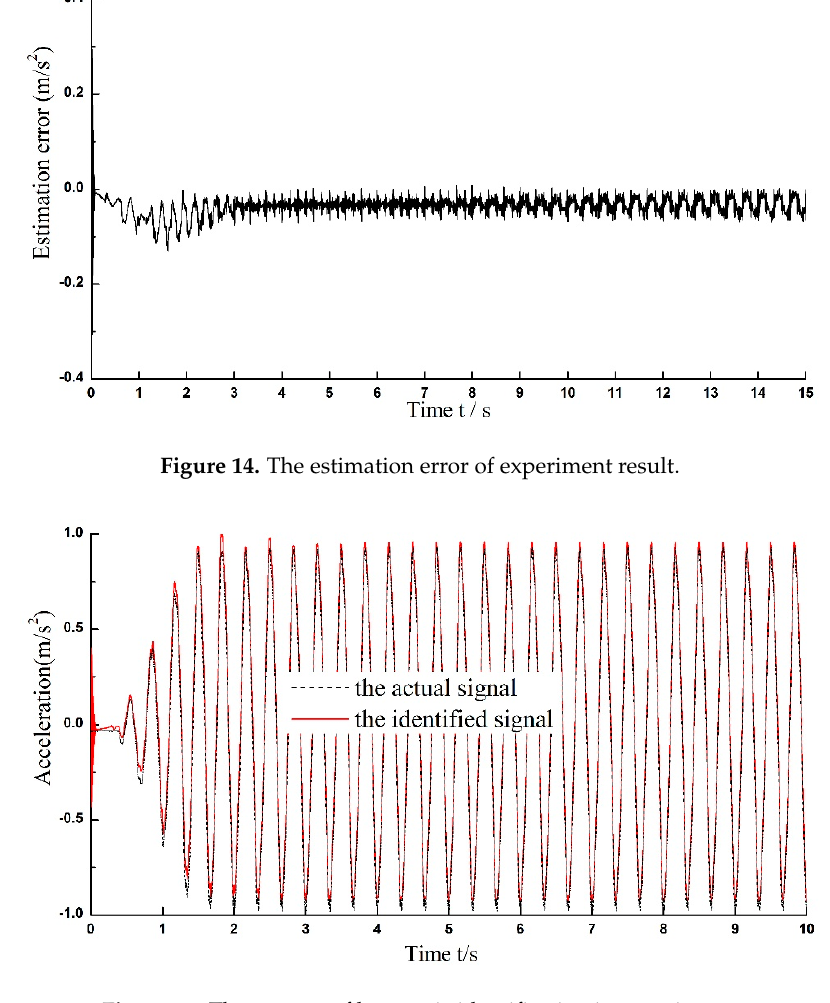
Figure 15. The process of harmonic identification in experiment.